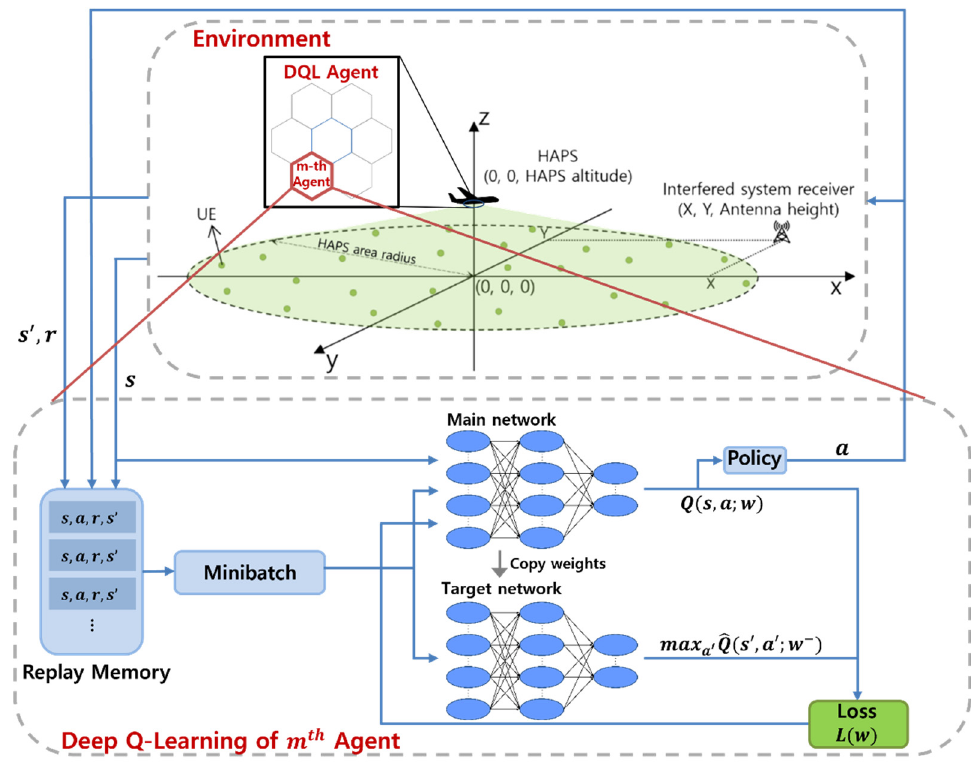
Figure 7. DQL-based HAPS power control architecture.